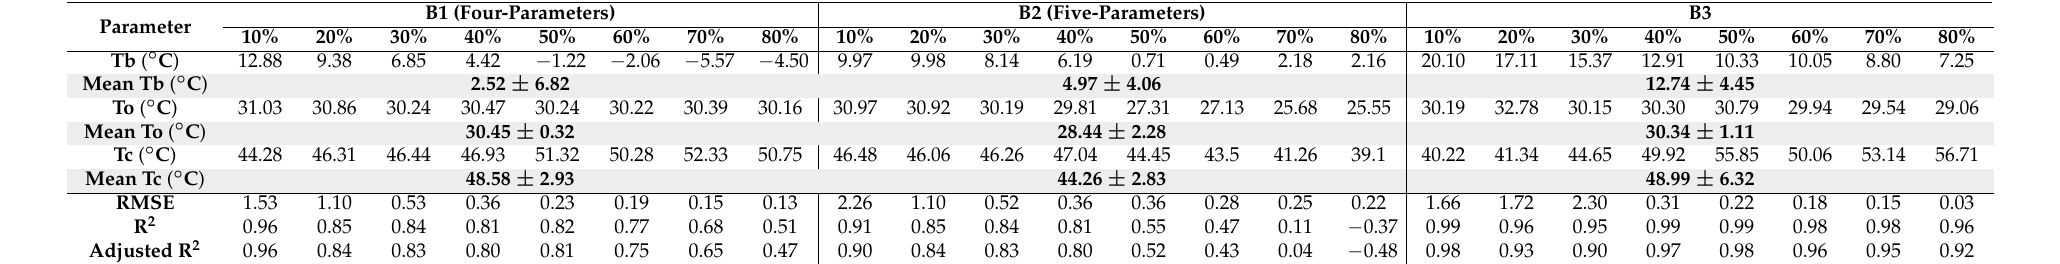
Table 6. Estimated parameters for beta models (B1–B3) of Salvia hispanica seeds. Root mean square of deviations (RMSE) and coefficient of determination (R 2 ) for the relationship between emergence